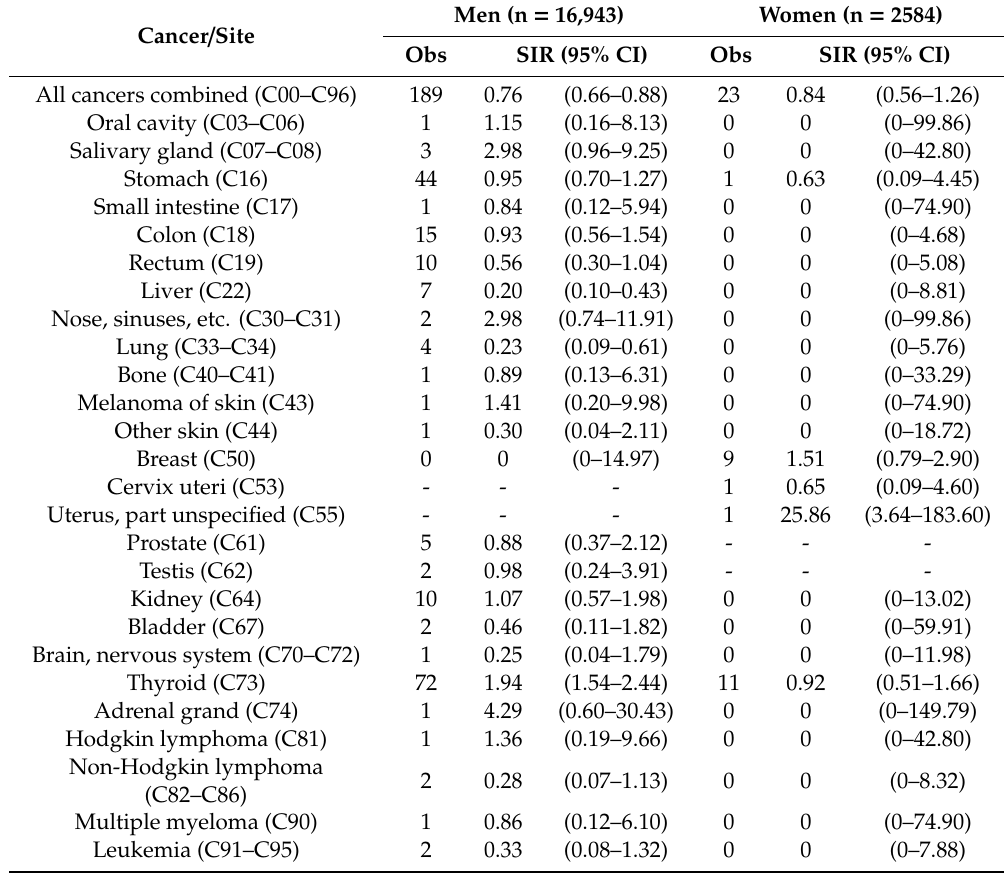
Table 4. Number of observed cases, SIR, and 95% CI among radiation workers in South